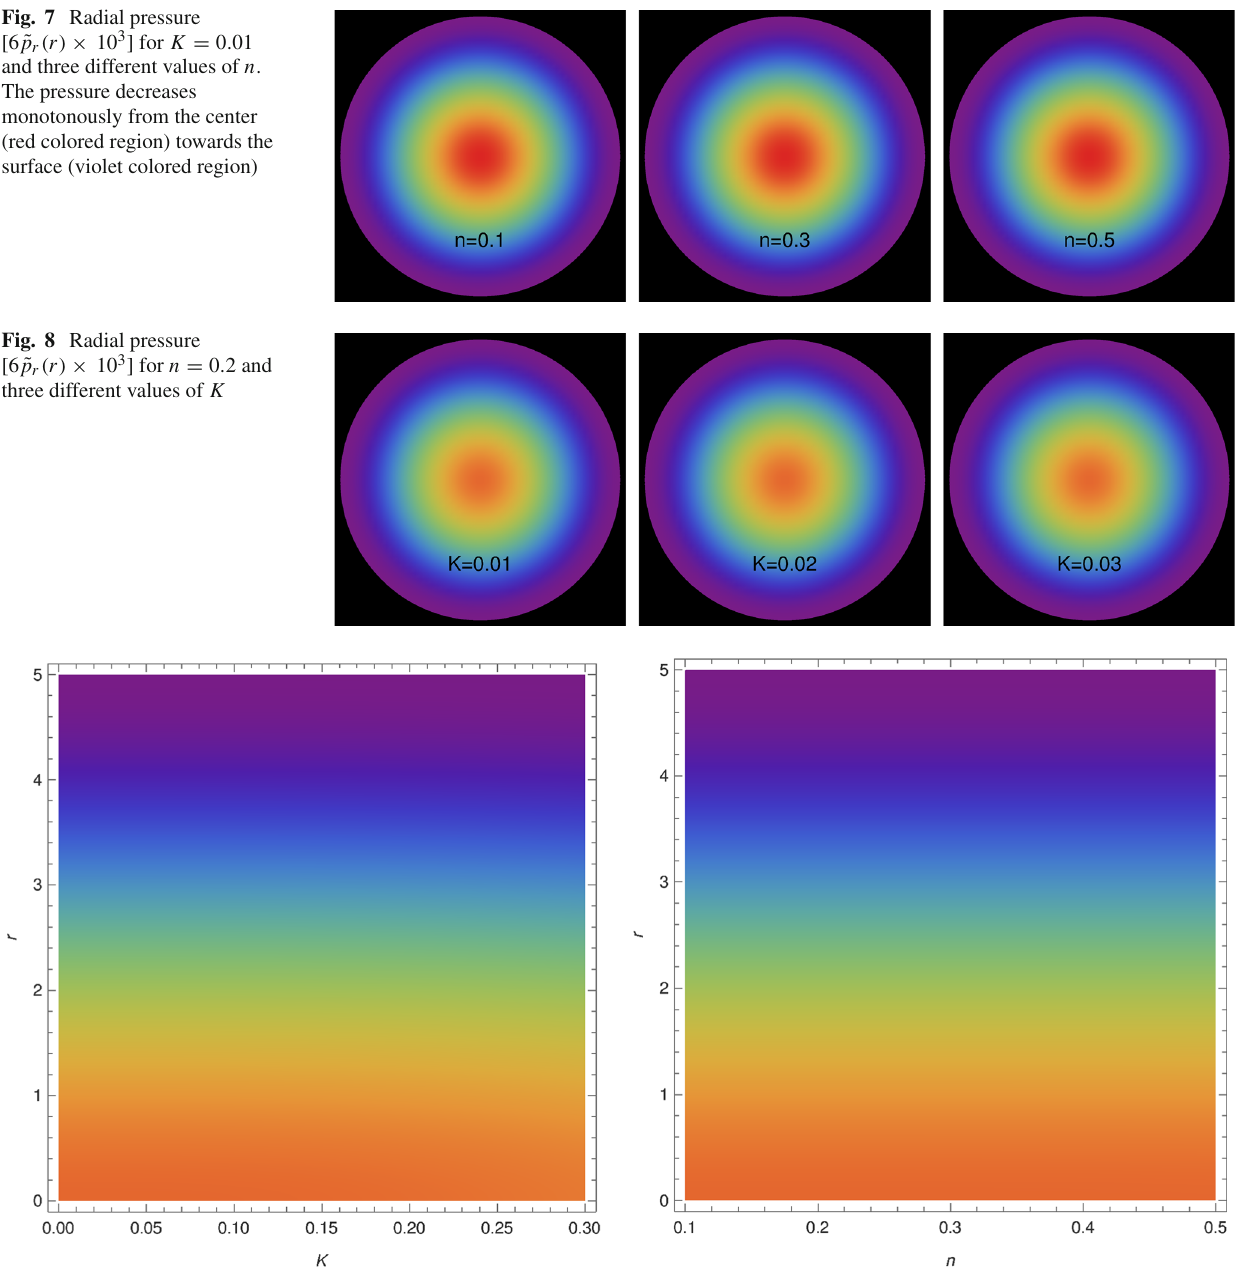
Fig. 7 Radial pressure [ 6 ˜ p ( r ) × 10 3 ] for K = 0 . 01 r and three different values of n . The pressure decreases monotonously from the center (red colored region) towards the surface (violet colored region)